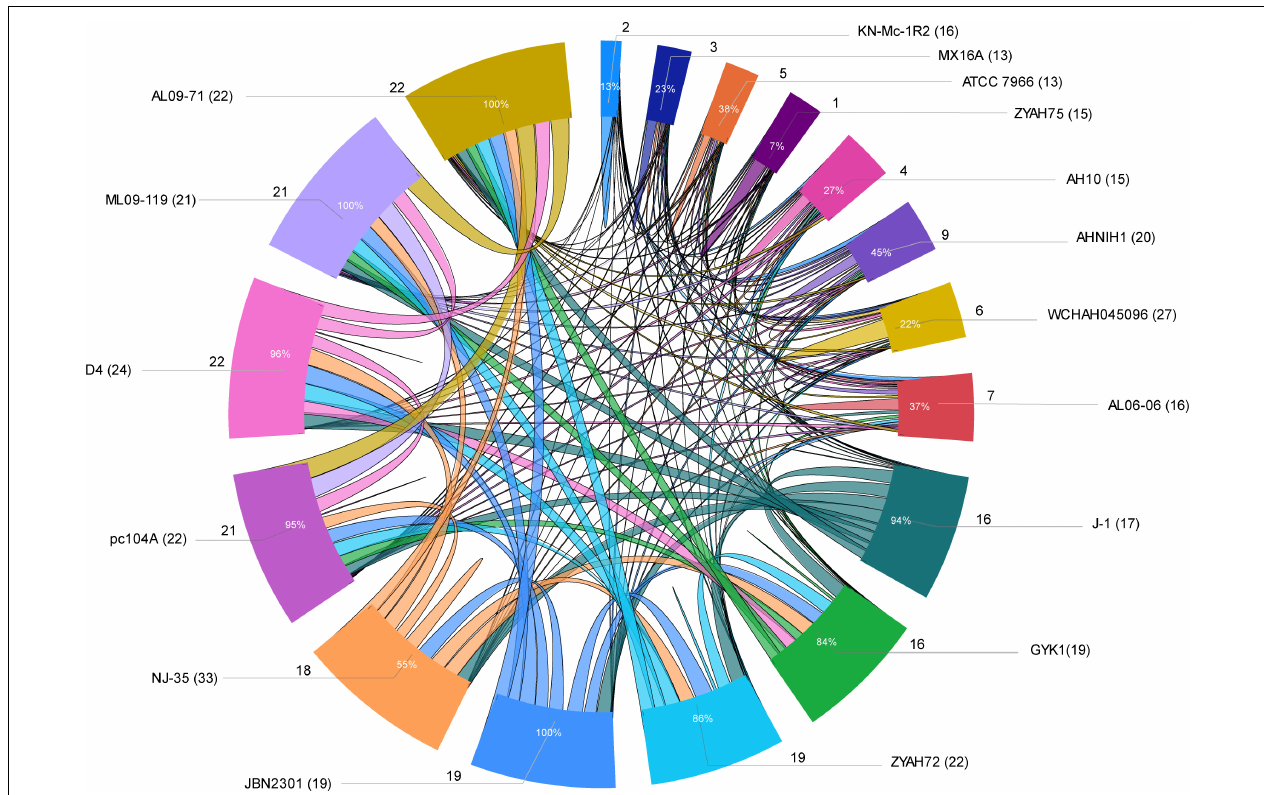
FIGURE 3 | Sharing of predicted genomic islands (GIs) among A. hydrophila strains. Ratio of GIs shared among strains. Distribution of the data is presented as the total number of predicted GIs, the total number of shared GIs, and their related percentages. The circle indicates the predicted GIs shared proportionally by the size of each arc; the names of the strains are indicated outside the circle with the number of predicted GIs in parentheses; the number of GIs shared is indicated by the lines and the proportion inside the arc; lines connecting strains indicate sharing of predicted